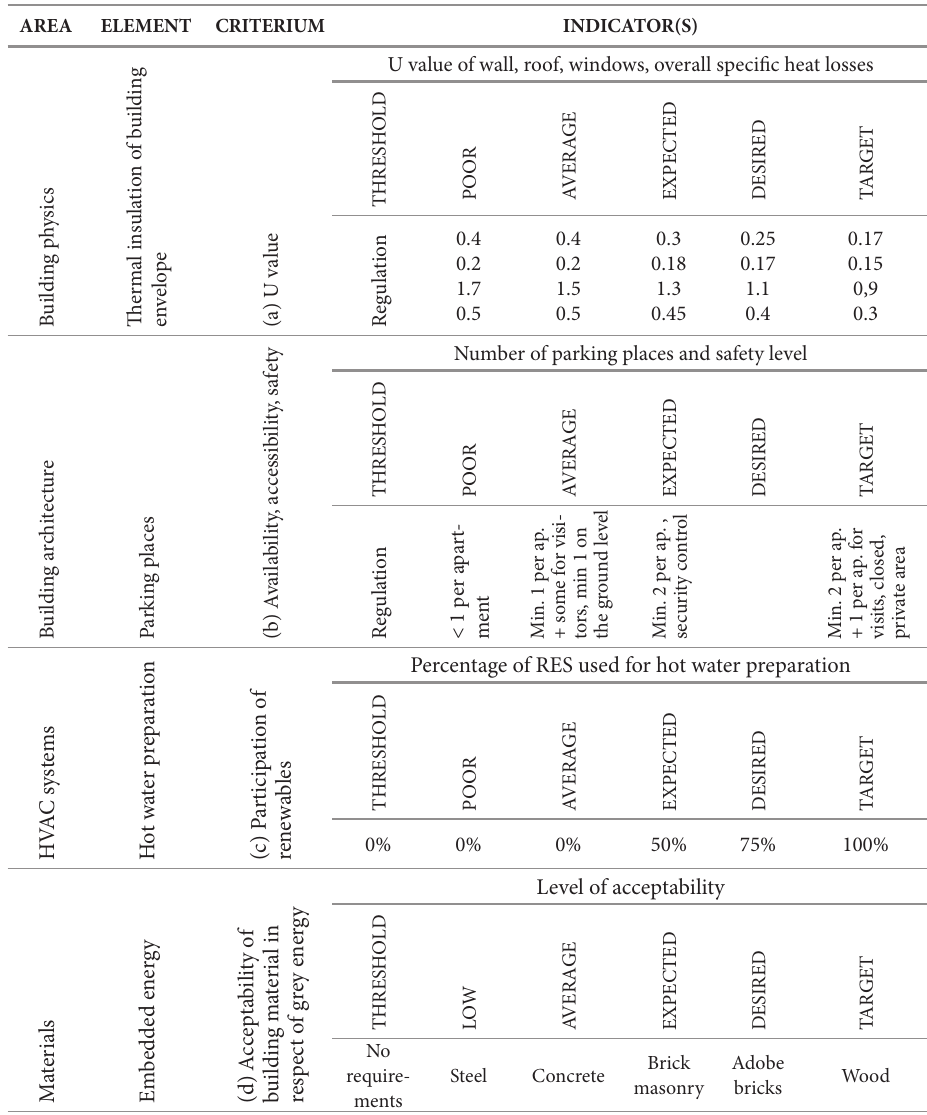
Table 2. Example of criteria described with (a) several measurable indicators, (b) several descriptive indicators, (c) with a single measurable indicator and (d) with a single descriptive indicator AREA ELEMENT